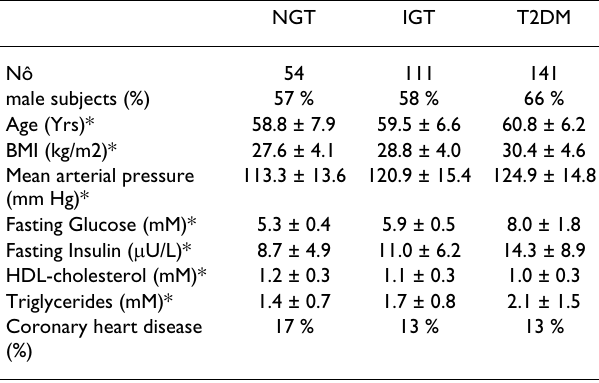
Table 1: Basic characteristics of the